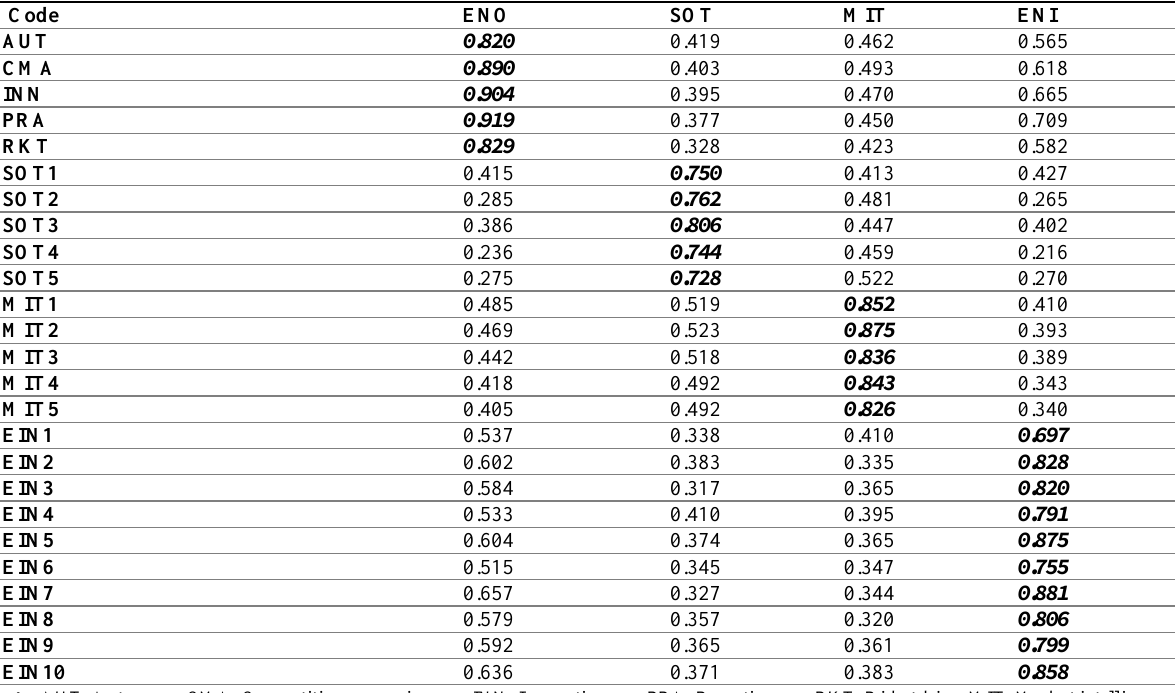
Table 7: Loadings and Cross-Loading (Stage